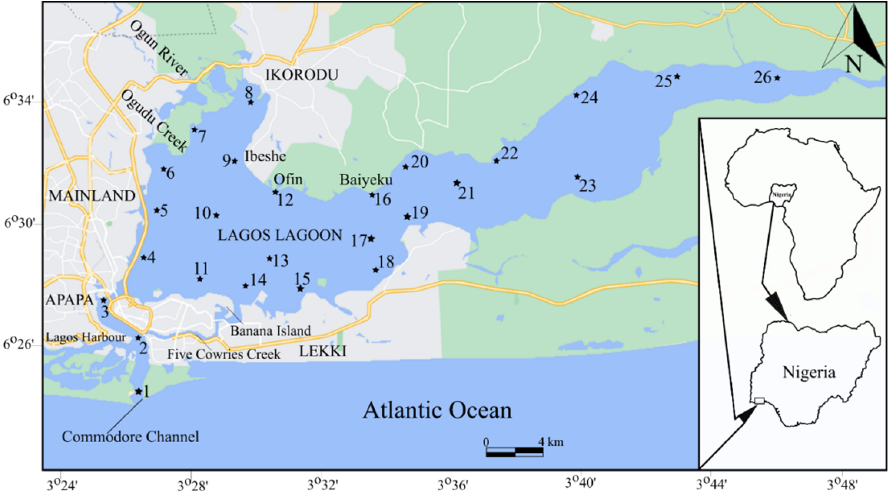
Figure 1. Sample sites within Lagos Lagoon, Nigeria (modified from Google map).